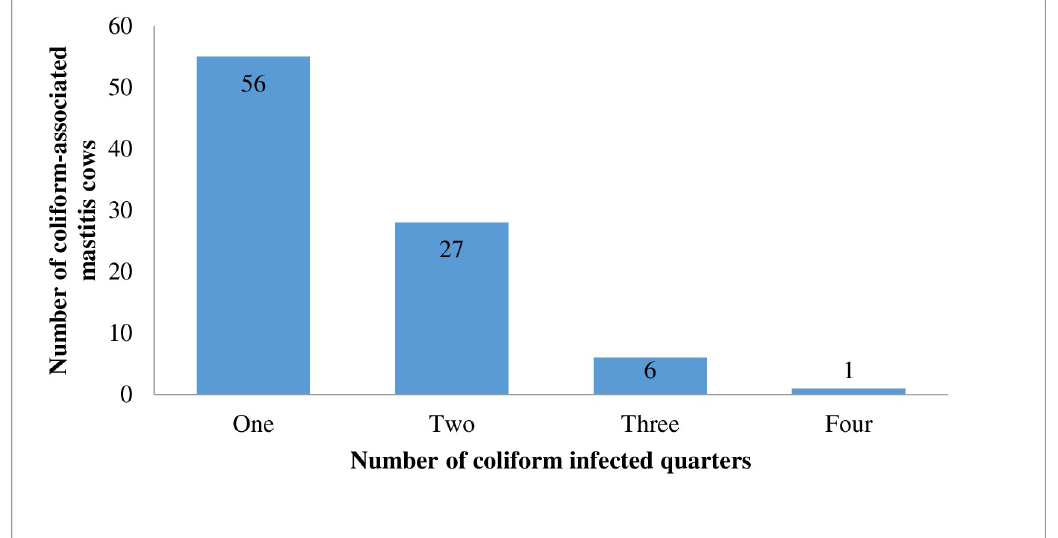
Fig 3. Number of quarters infected for coliform-associated mastitis